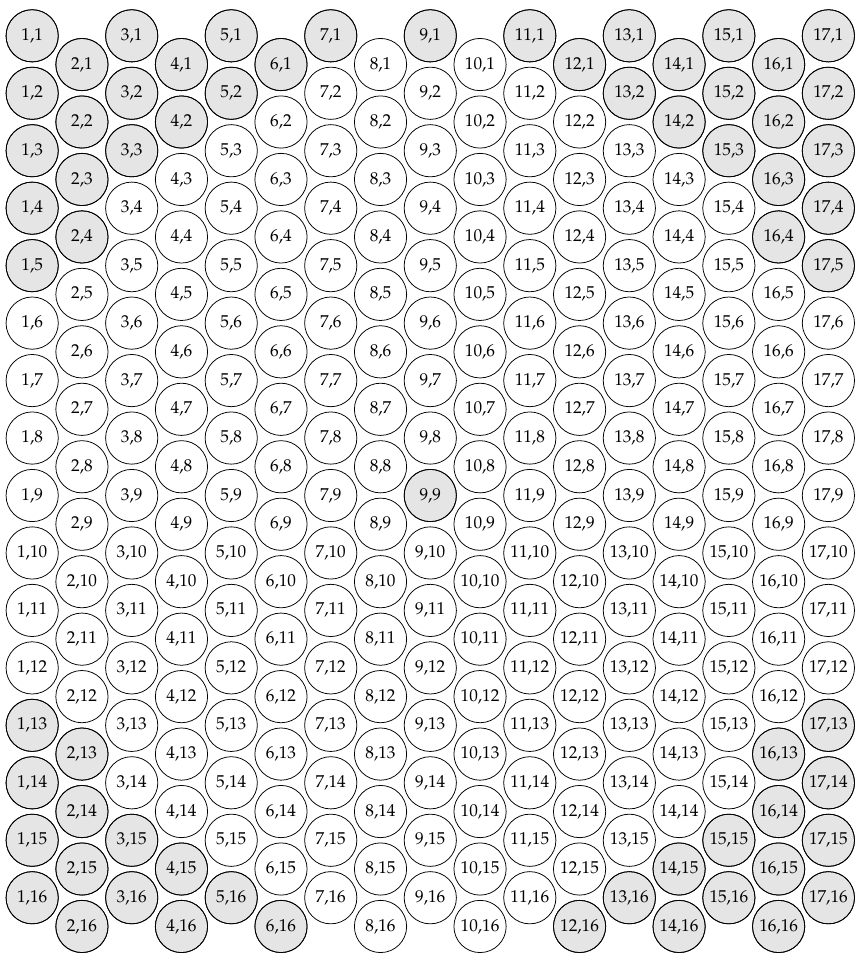
Figure 18. Scheme of wells in a slate library used in ecIRT. Gray highlighted wells are not present due to circular shape or drilled through the library as gas outlet (9,9) or to ease handling (2,4), (2,13), (16,4) and